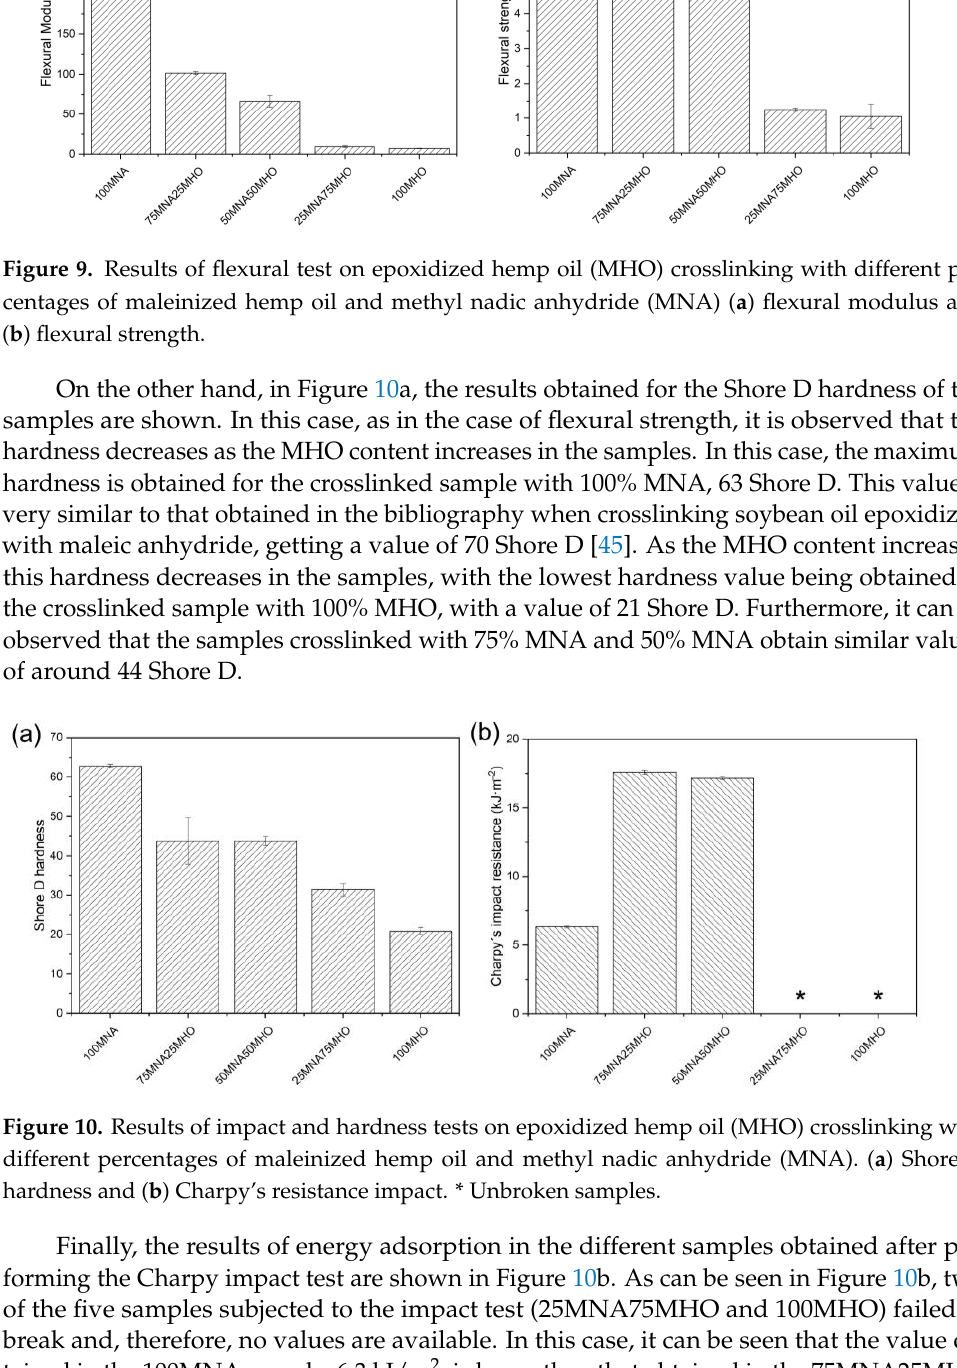
Figure 9. Results of flexural test on epoxidized hemp oil (MHO) crosslinking with different percent- ages of maleinized hemp oil and methyl nadic anhydride (MNA) ( a ) flexural modulus and ( b ) flex- ural strength.